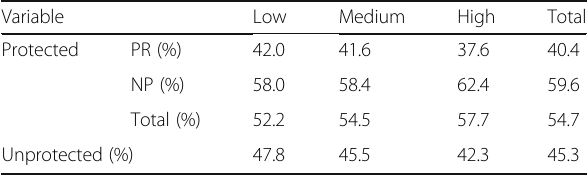
Table 5 Areas of the potential habitat suitability map of huemul in Santa Cruz province (Table 4) classified according their protection status: Provincial natural reserves (PR) and National Parks (NP) and unprotected, where low is 40 – 50%, medium is 50 – 70%, and high is 70 – 100% Variable